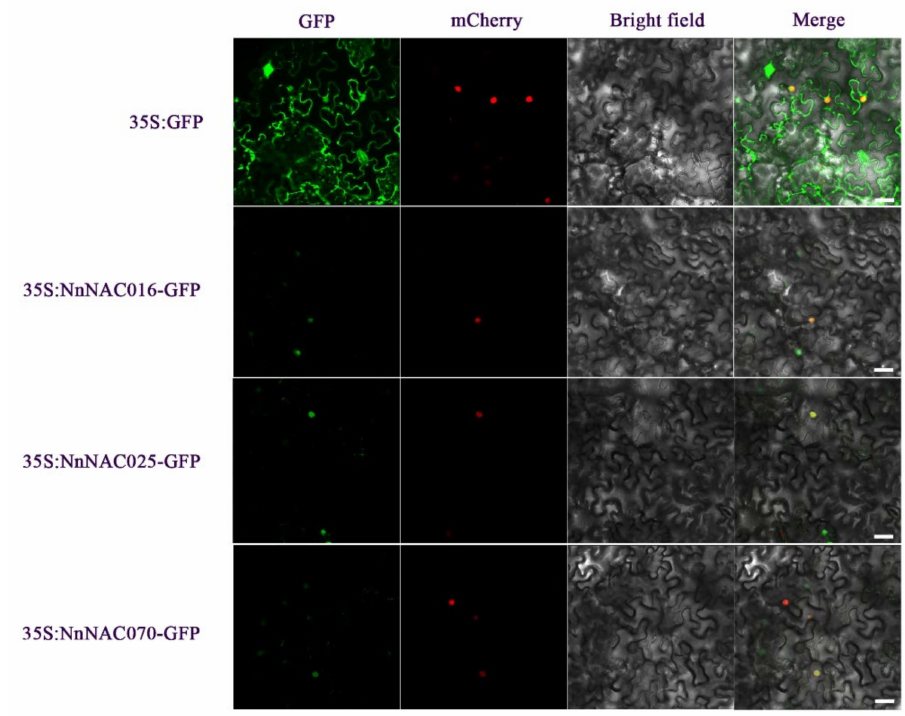
Figure 6. Subcellular localization of the soybean NAC proteins. The first row of pictures above is a con- trol, and those below it are the NnNAC016, NnNAC025, and NnNAC070 proteins. Scale bars = 25 µ m.